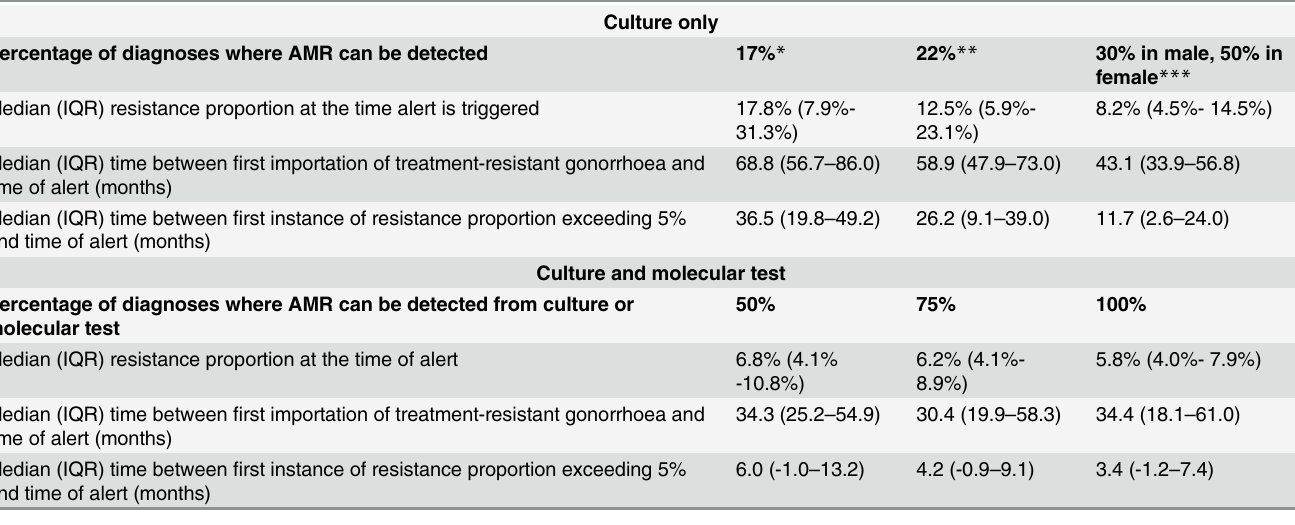
Table 4. Impact of molecular test on AMR surveillance over 1000 simulation runs.